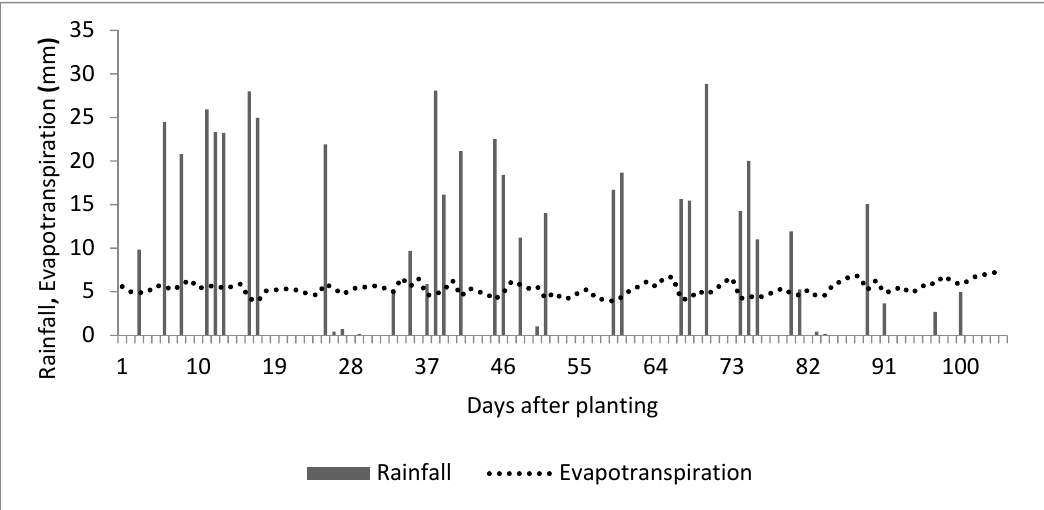
Figure 5. Rainfall and evapotranspiration for the September to December 2014 growing season